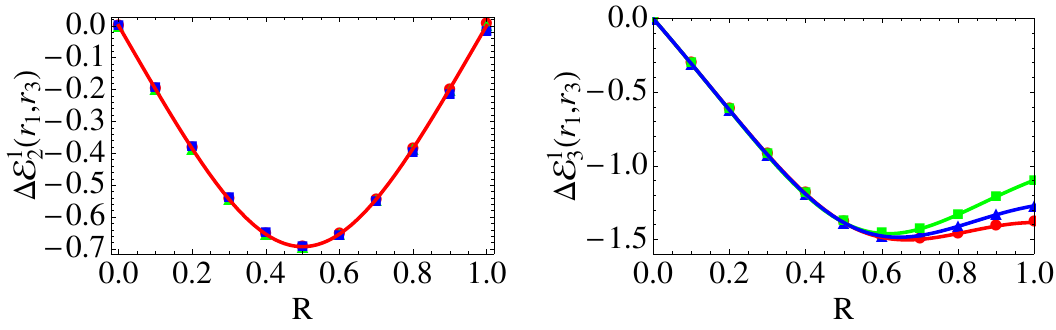
Figure 7 . Results for k (cid:16) 1 and p (cid:16) 4 (cid:25) with n (cid:16) 2 (left) and n (cid:16) 3 (right). For each case we present three curves corresponding to r 1 (cid:16) r 3 (cid:16) R (circles), r 1 (cid:16) 2 R and r 3 (cid:16) 3 R (triangles), and 2 5 5 r 1 (cid:16) R , r 3 (cid:16) 2 R (squares). For n (cid:16) 2 all three sets of data are identical, since in this case the 3 3 negativity only depends on the sum r 1 (cid:0) r 3 (cid:16) R and equals minus the 2nd R(cid:19)enyi entropy. The symbols are numerical data and the curves are obtained from the formula (2.3).